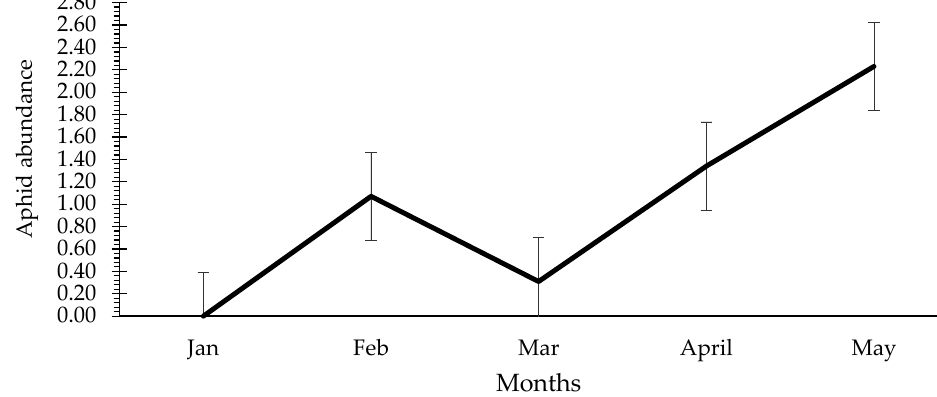
Figure 1. Aphid abundance across sampling time